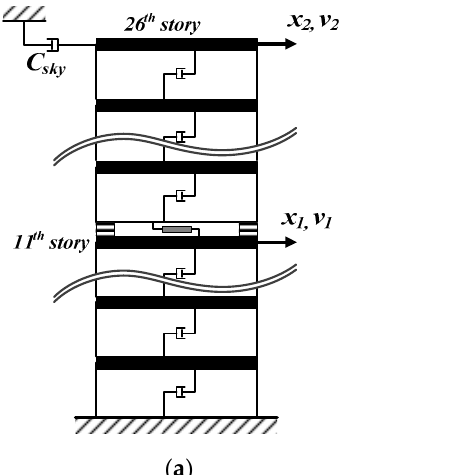
( b ) Figure 13. Comparison of the 11th-story drift time histories: ( a ) responses to EV1, ( b ) responses to EV2.